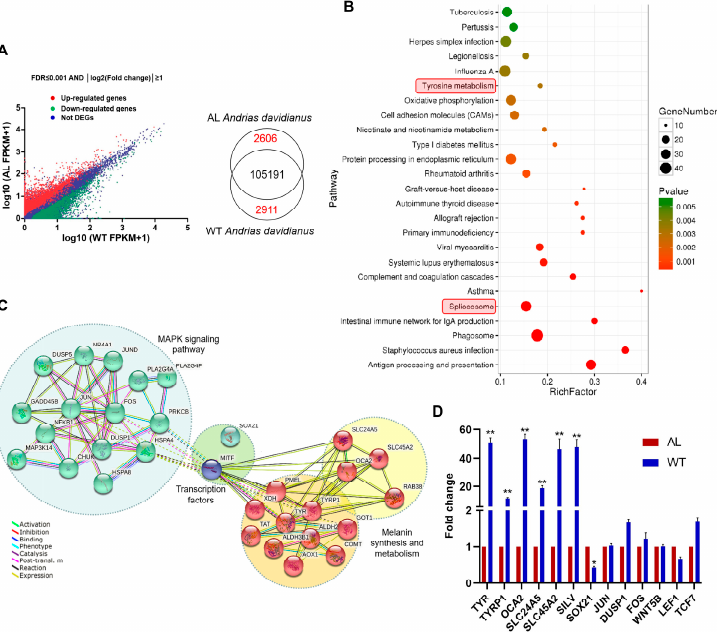
Figure 2. Sequencing analysis between wild-type (WT) and albino (AL) Andrias davidianus skin. ( A ) Genes di ff erentially expressed in WT compared with AL Andrias davidianus skin. ( B ) KEGG enrichment analysis of DEGs shows the top 25 KEGG pathways. The red box marks the pathways associated with pigmentation and gene splicing. ( C ) Protein-to-protein interaction (PPI) network constructed by DEGs of pigmentation, melanogenesis, and pigmentation-related pathways. ( D ) Validation of selected genes using qRT-PCR. Fold changes are calculated by normalizing expression relative to GAPDH . * represents p value ≤ 0.05 and ** represents p value ≤ 0.01.